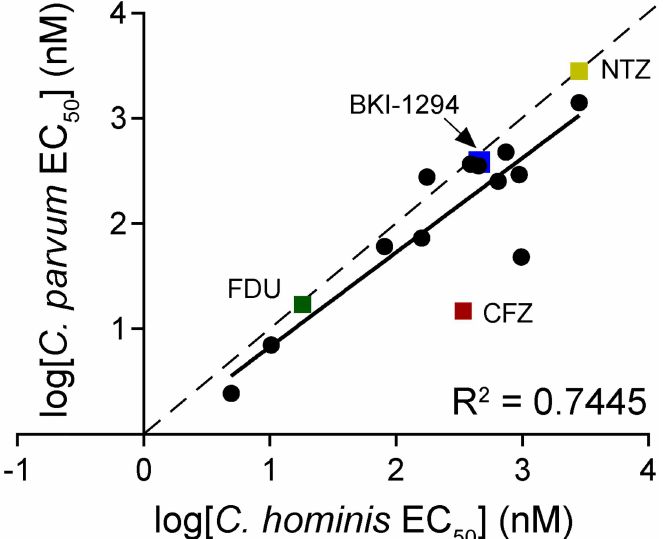
Fig 3. Screening hits show activity against two species of Cryptosporidium . Twelve filtered hits and multiplecontrols were tested against C . parvum and C . hominis for cross-species confirmation. Data points are log-transformed EC 50 values. Controls and compoundsof interest are denotedwith a square symbols and labeled.The correlationis shown by the trendlineslope (solid line, m = 0.7445)compared to a perfect linear correlation(dotted line, m = 1).